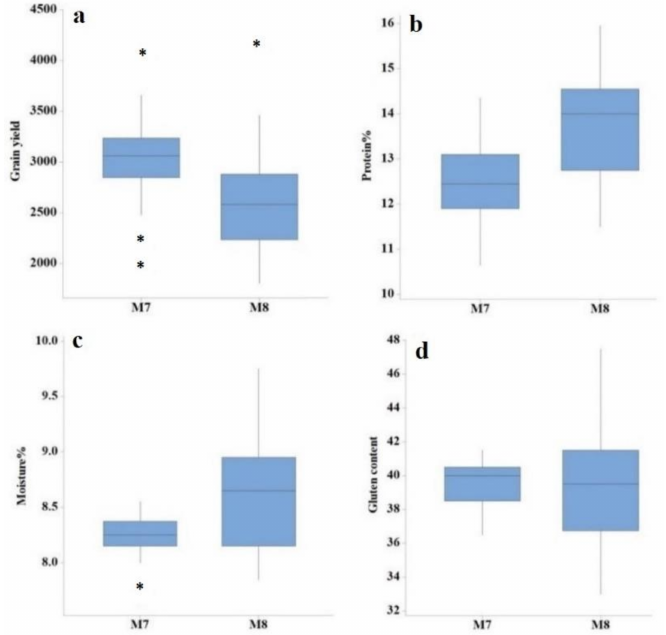
Figure 2. Box plots showing median, minimum, maximum, and mean values: ( a ) grain yield;